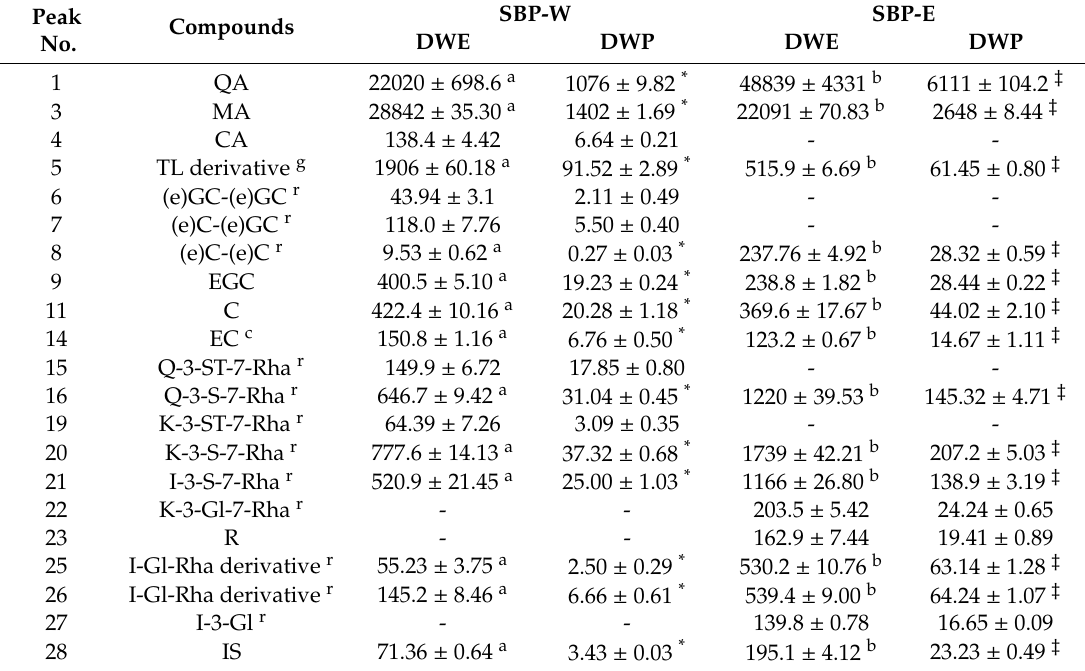
Table 4. Quantification of phytochemicals, in µ g / g DWE and µ g / g DWP.